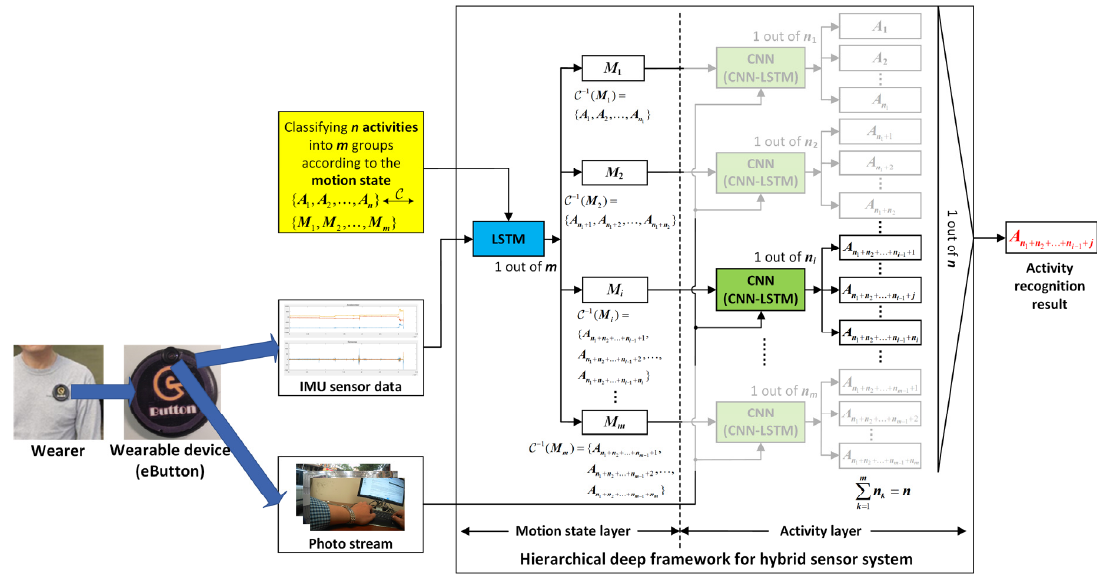
Figure 1. Overall architecture of the proposed hierarchical deep fusion